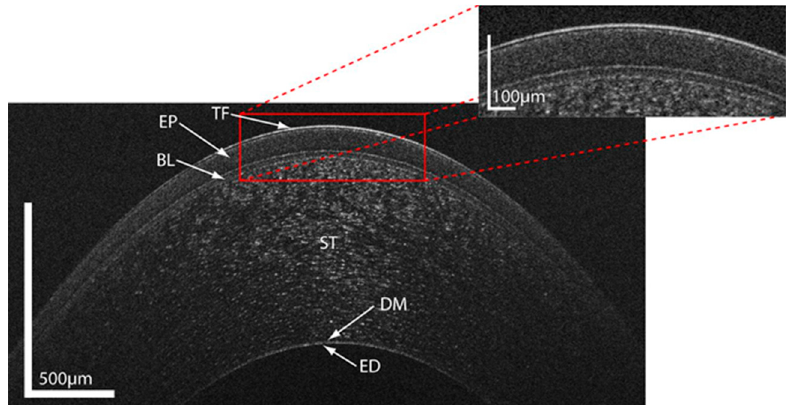
Figure 1. Ultrahigh resolution optical coherence tomography image of the healthy human cornea. TF = tear film; EP = corneal epithelium; BL = Bowman’s layer; ST = corneal stroma; DM = Descemet’s membrane; ED = corneal endothelium. The scales for the x - and y -axis are indicated. Reprinted from Werkmeister et al., 2013 [12].